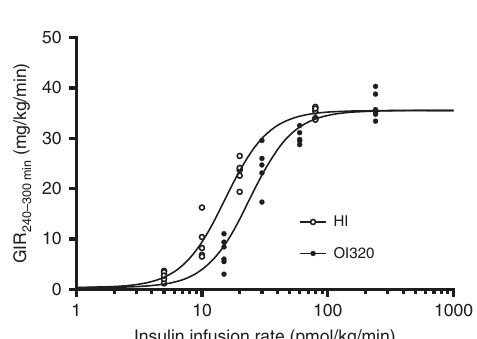
Fig. 4 Hyperinsulinemic, euglycemic clamp experiment. A representative dose response plot (GIR = glucose infusion rate) from a 5-h hyperinsulinemic, euglycemic clamp experiment in healthy and conscious rats performed to determine the potency of OI320 (black circles) relative to human insulin (white circles). The dots represent the average GIR during the last 60min of the experiment in each rat ( n = 6 rats per dose (group); independent experiments). Similar dose response studies were performed in healthy and conscious pigs and dogs as indicated in (Fig. 2d) and; see Table 1 for 95% con fi dence